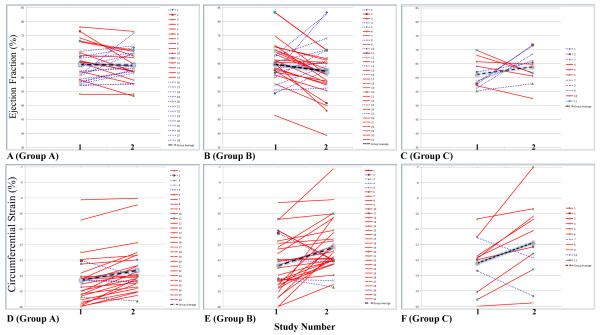
Serial ejection fraction (EF) and circumferential strain (εcc). Red, indicates decreased EF and εcc magnitude; blue, indicates increase EF and εcc magnitude and black, indicates mean EF and εcc values. Panels A-C show EF of each subject plotted serially; there was no significant change in mean EF across all three groups. Individually 14/28 (50%) in Group A, 21/31(68%) in Group B and 5/11 (45%) in Group A to B transition had decrease EF, while 14/28 (50%), 10/31 (32%) and 6/11 (55%) of the individuals in the respective groups had increase EF. Panels D-F show εcc of each subject plotted serially; although all three groups had lower absolute εcc on the follow-up study, only Group B subjects had a significant decline (p = 0.007). Individually εcc magnitude decreased more consistently across all three groups, with 24/28 (86%) in Group A, 26/31 (84%) in Group B and 9/11 (82%) in Group A to B. Unlike EF, only a small fraction of the individuals have improvement of εcc magnitude on follow-up study with 4/28 (14%), 5/31 (31%) and 2/11 (18%) of the individuals in the respective group having an increase εcc value on follow-up study.